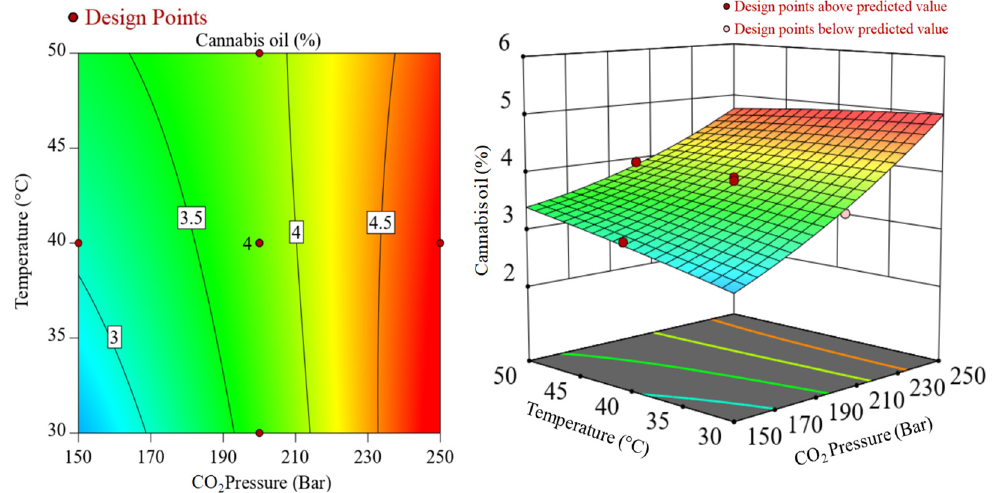
Figure 2. Interactions between CO 2 pressure and temperature during SCCO 2 extraction at a constant extraction time of 1.5 h.